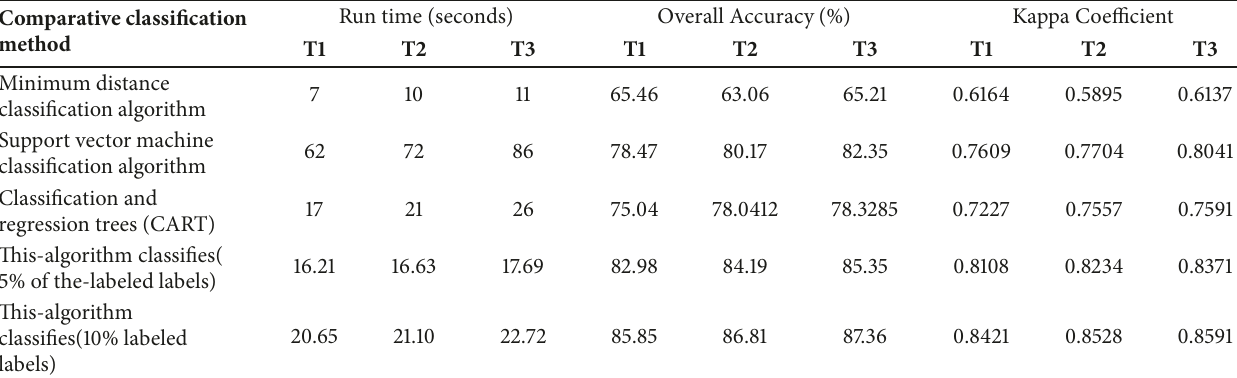
Table 3: The comparison of overall accuracy and Kappa coefficient under different classifier algorithm of AVIRIS data.